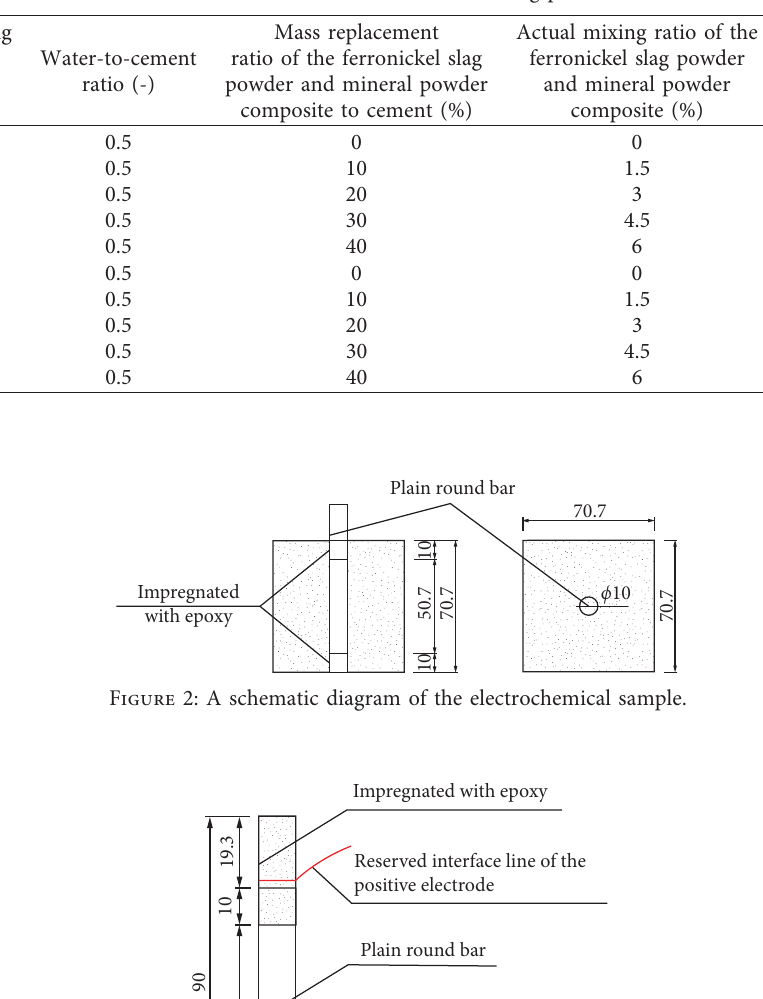
Table 5: The electrochemical testing plan.